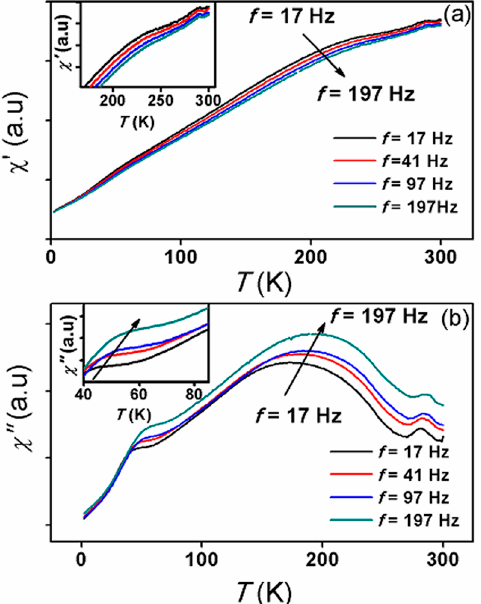
Figure 12. ( a ) The real χ (cid:48) ( T , f ) ; and ( b ) the imaginary χ (cid:48)(cid:48) ( T , f ) components of the ac susceptibility as a function of temperature at several frequencies.